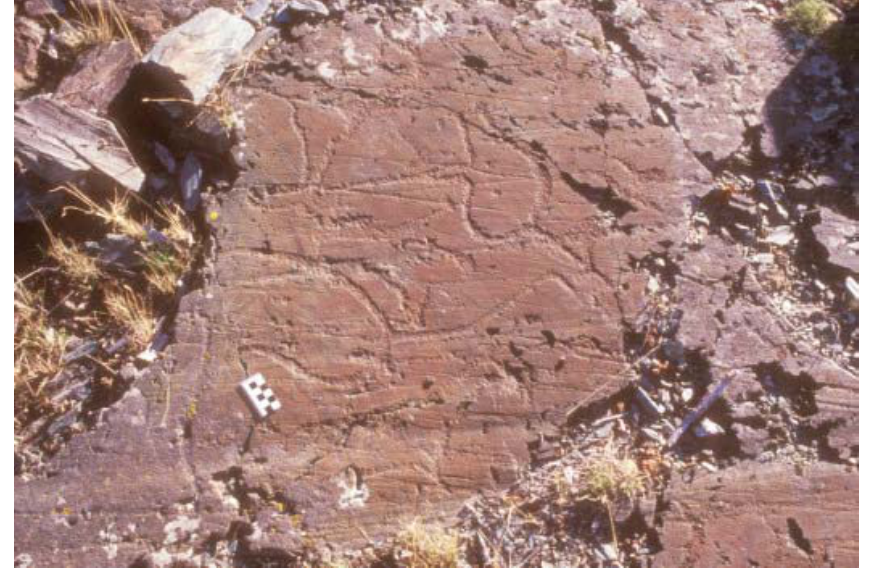
Figure 26. Two ostriches, two horses and an uncertain element. Pre-Bronze Age. Aral Tolgoi.